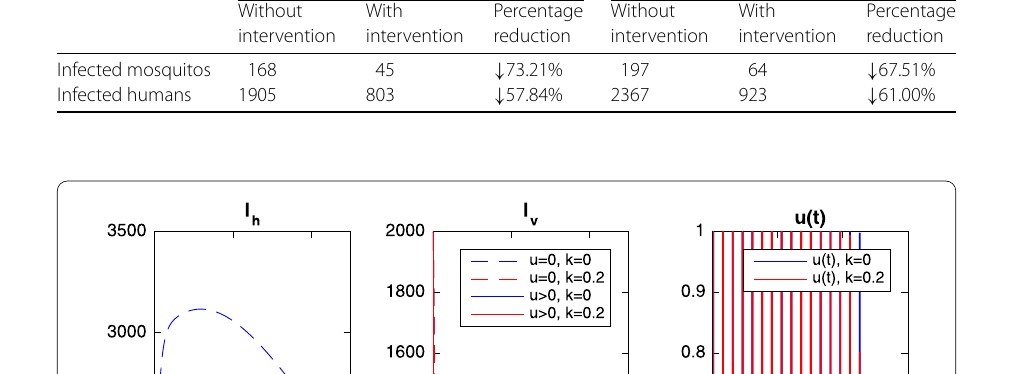
Table 4 Number of humans and mosquitos infected on day 500 with seasonal influence Populations